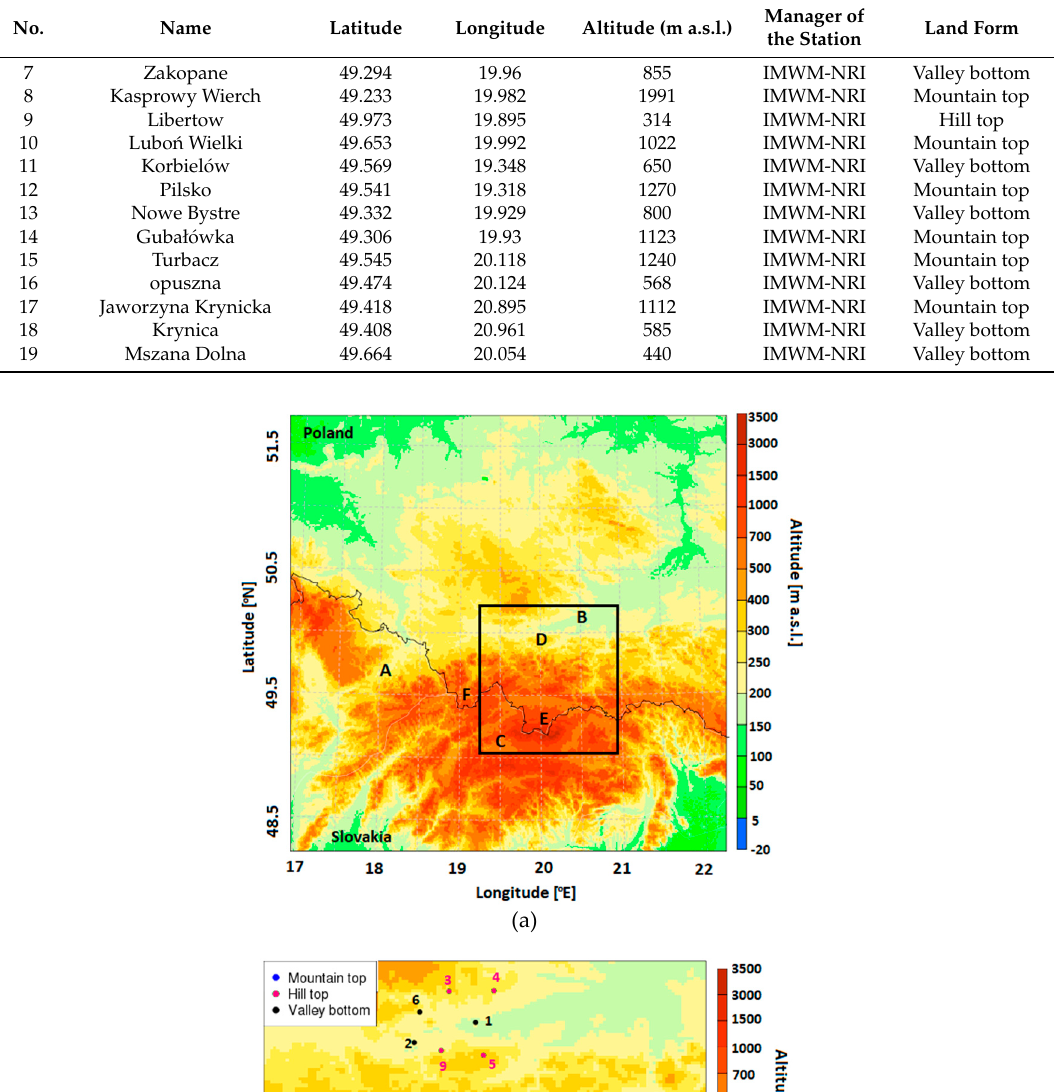
Table 2. Configurations of models used in the study. AROME, Application of Research to Operations at Mesoscale; CMC, canonical model configuration; HARMONIE, Limitée Adaptation Dynamique Développement International (ALADIN) High ‐ Resolution Limited Area Model (HIRLAM) Regional/Mesoscale Operational Numerical Weather Prediction (NWP) in Europe AROME; ALARO NH, ALADIN ‐ AROME nonhydrostatic.